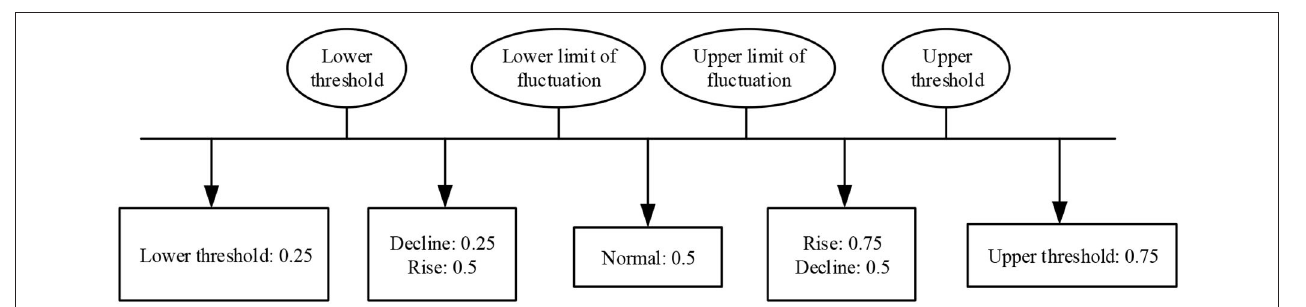
Frontiers in Energy Research |